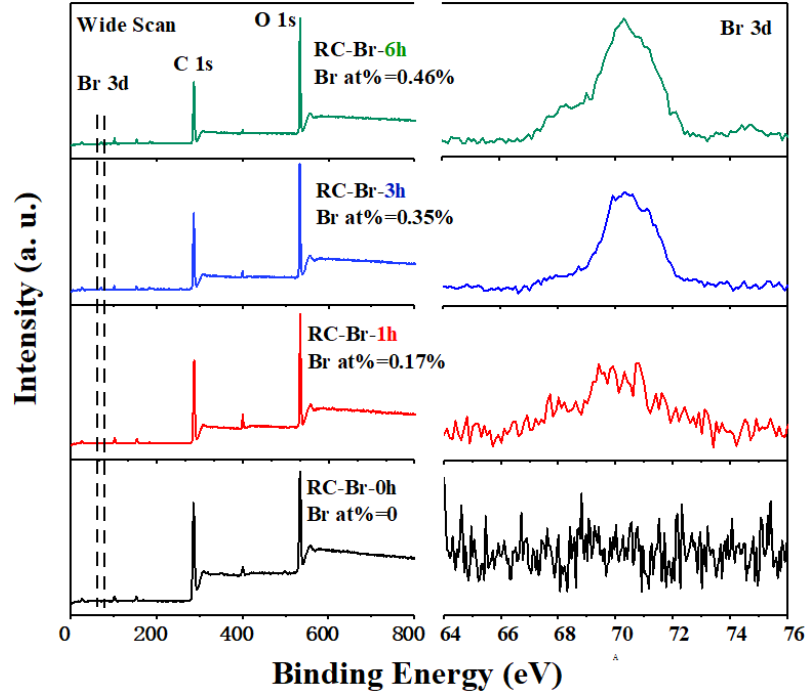
Figure 2. XPS spectrum of the 2-bromoisobutyryl bromide (2-BIBB)-initiated RC membranes with different reaction times of 1, 3, and 6 h.